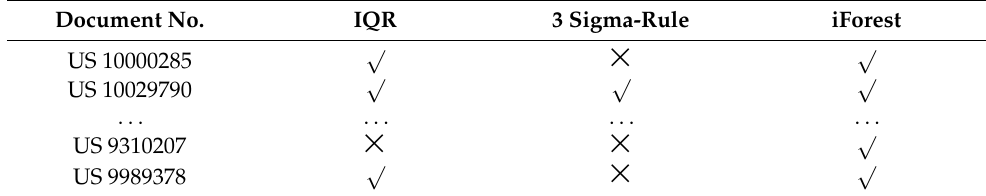
Figure 8. The result of document embedding (iForest). Table 7. Result of Ensemble Outlier Detection.